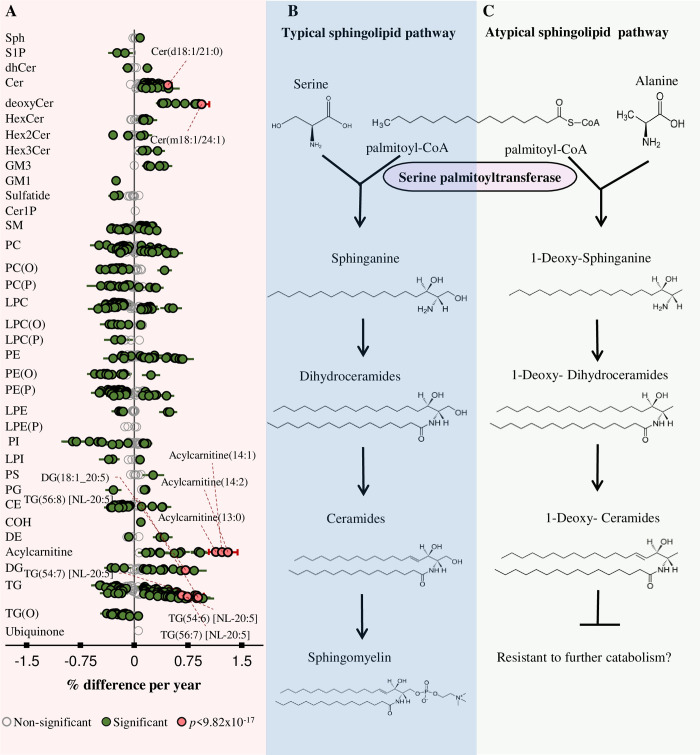
Associations between age and plasma lipid species.(A) Linear regression between age and log-transformed lipid species concentration on 10,339 individuals adjusting for sex, BMI, total cholesterol, HDL-C, and triglyceride levels. Grey circles show nonsignificant species, green show species with p < 0.05, and pink show the 10 most significant species after correction for multiple comparisons (p < 9.82 × 10−17). Whiskers represent 95% confidence intervals. (B) The typical sphingolipid pathway in which SPT joins canonical substrates serine and palmitoyl-CoA to produce the sphinganine base, a precursor for simple and complex sphingolipids. (C) SPT can also utilise alanine instead of serine to produce 1-deoxysphinganine and deoxyCers that lack an OH group at the C1-position. See S1 Data for the underlying data. BMI, body mass index; CE, cholesteryl ester; Cer, ceramide; Cer-1-P, ceramide-1-phosphate; COH, free cholesterol; DE, dehydrocholesterol; deoxyCer, deoxyceramide; DG, diacylglycerol; dhCer, dihydroceramide; GM1, GM1 ganglioside; GM3, GM3 ganglioside; HDL-C, high-density lipoprotein cholesterol; HexCer, monohexosylceramide; Hex2Cer, dihexosylceramide; Hex3Cer, trihexosylceramide; LPC, lysophosphatidylcholine; LPC(O), lysoalkylphosphatidylcholine; LPC(P), lysoalkenylphosphatidylcholine; LPE, lysophosphatidylethanolamine; LPE(P), lysoalkenylphosphatidylethanolamine; LPI, lysophosphatidylinositol; NL, neutral loss; OH, hydroxyl; PC, phosphatidylcholine; PC(O), alkylphosphatidylcholine; PC(P), alkenylphosphatidylcholine; PE, phosphatidylethanolamine; PE(O), alkylphosphatidylethanolamine; PE(P), alkenylphosphatidylethanolamine; PG, phosphatidylglycerol; PI, phosphatidylinositol; PS, phosphatidylserine; SM, sphingomyelin; Sph, sphingosine; SPT, serine palmitoyltransferase; S-1-P, sphingosine-1-phosphate; TG, triacylglycerol; TG(O), alkyl-diacylglycerol.